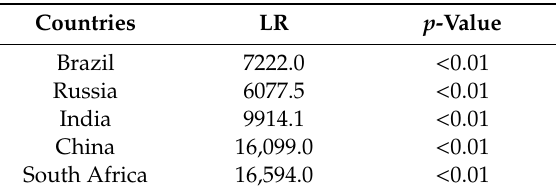
Table 4. Linearity